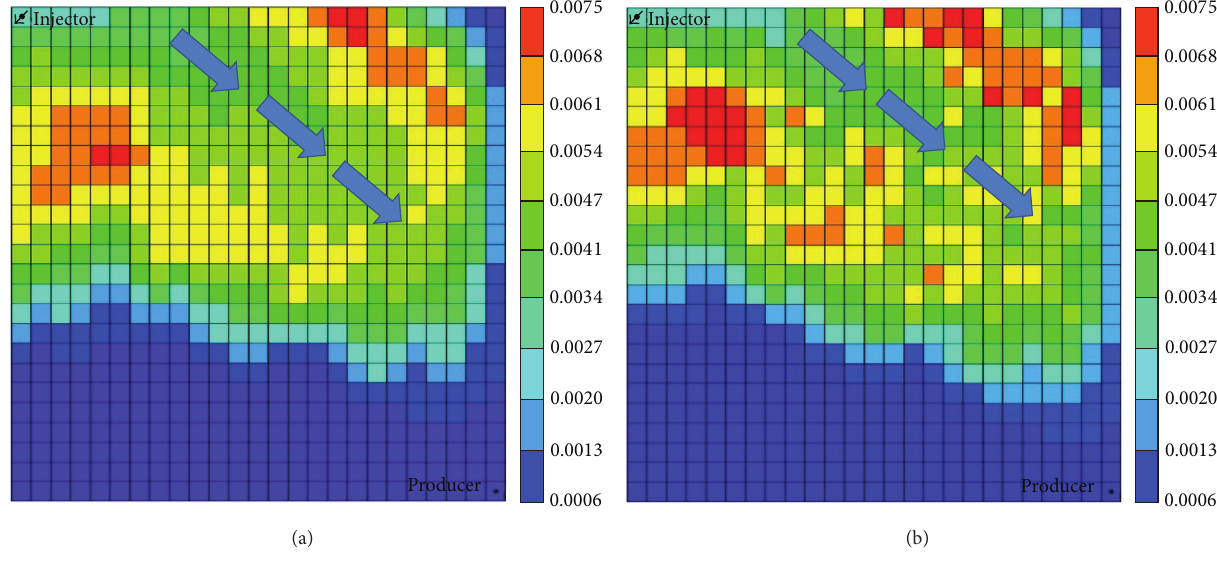
Figure 8: Comparison between viscosity (kg/m ⋅ s) distributions from using different matching functions: (a) constant RRF and (b) RRF = 𝑎